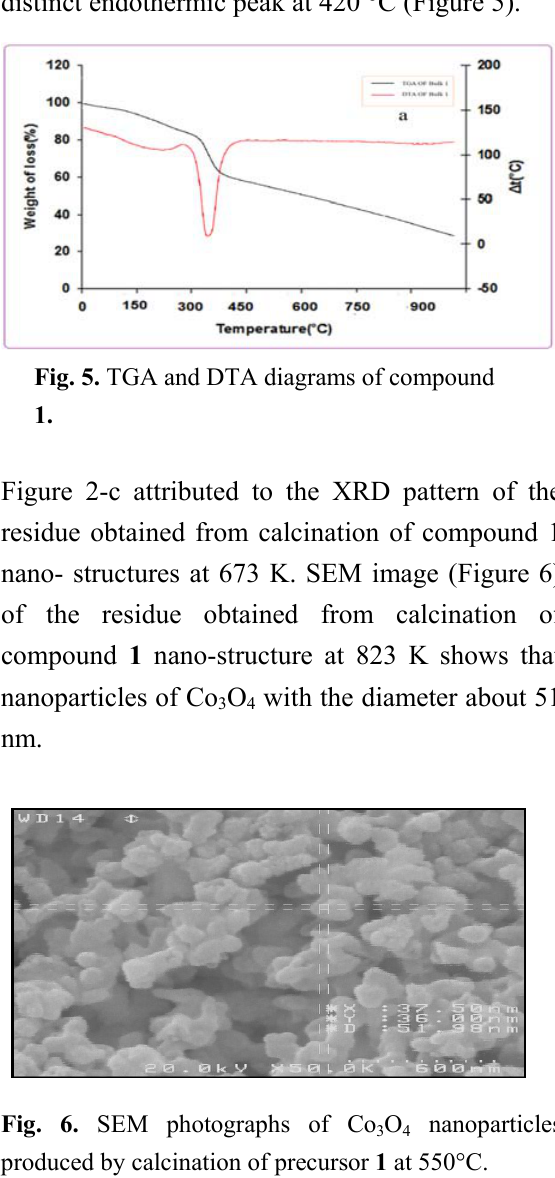
O nanoparticles 3 4